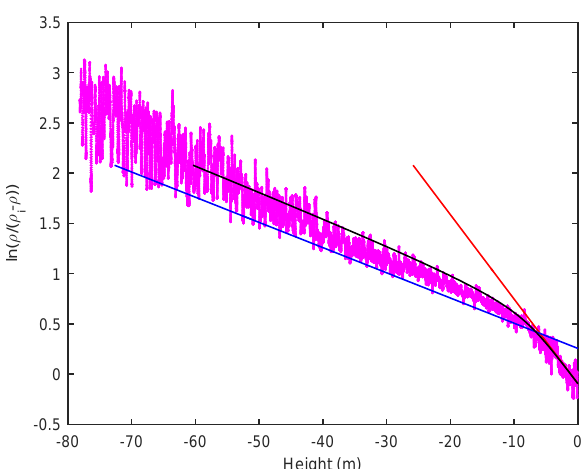
Figure 8. Profiles of ln( ρ / ( ρ i − ρ )) for ice core B39. Measured values (magenta line), modelled values using Herron and Langway Stage 1 (red) and Stage 2 (blue) densification rates, and modelled values using the transition model with ρ T = 580 kg m − 3 , M = 7 (black line).